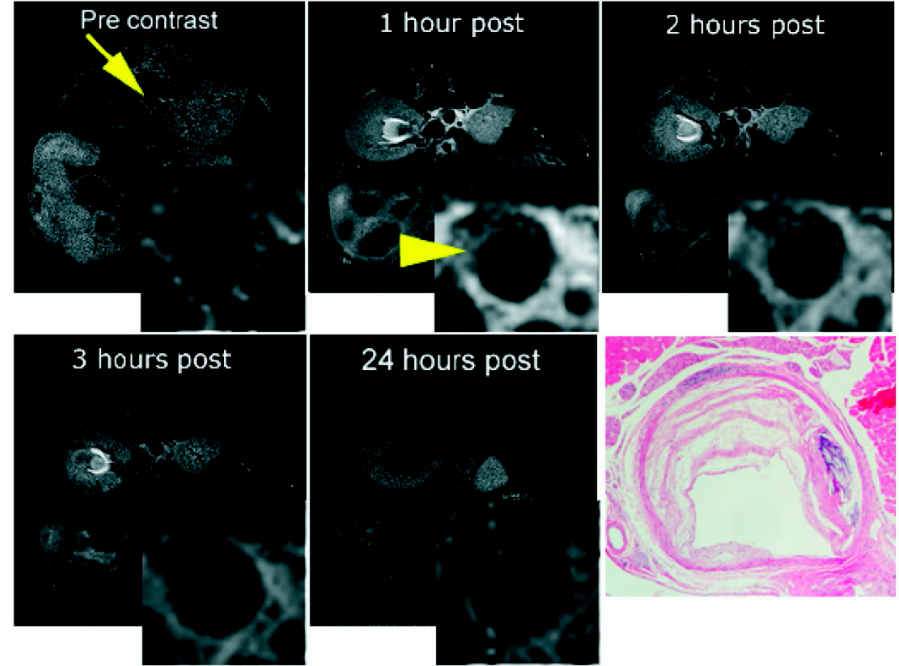
Figure 13. In vivo MRI of an ApoE − / − mouse before (arrow) and after P947 injection (arrowhead). After injection, significant contrast-enhancement appears in the atherosclerotic aortic wall as shown on the inset images of the aorta. Delineation of plaque morphology after contrast-enhancement is clearly improved (arrowhead). The bottom-right panel is the matched pathologic section. Reproduced with permission from Lancelot et al., 2008 [82].